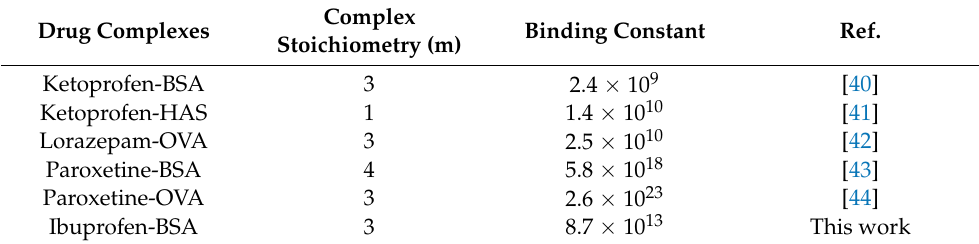
Table 2. Characteristics of drug complexation with OVA, BSA, and HAS. Drug Complexes